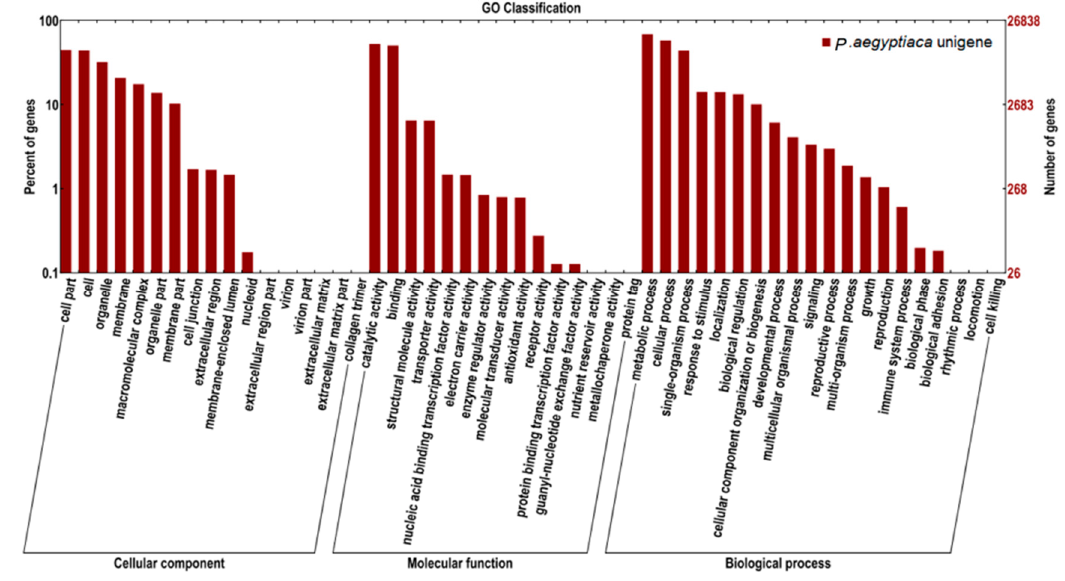
Figure 3. GO category distribution of P. aegyptiaca transcripts among level 1 GO categories: Biological process, molecular function, and cellular component.